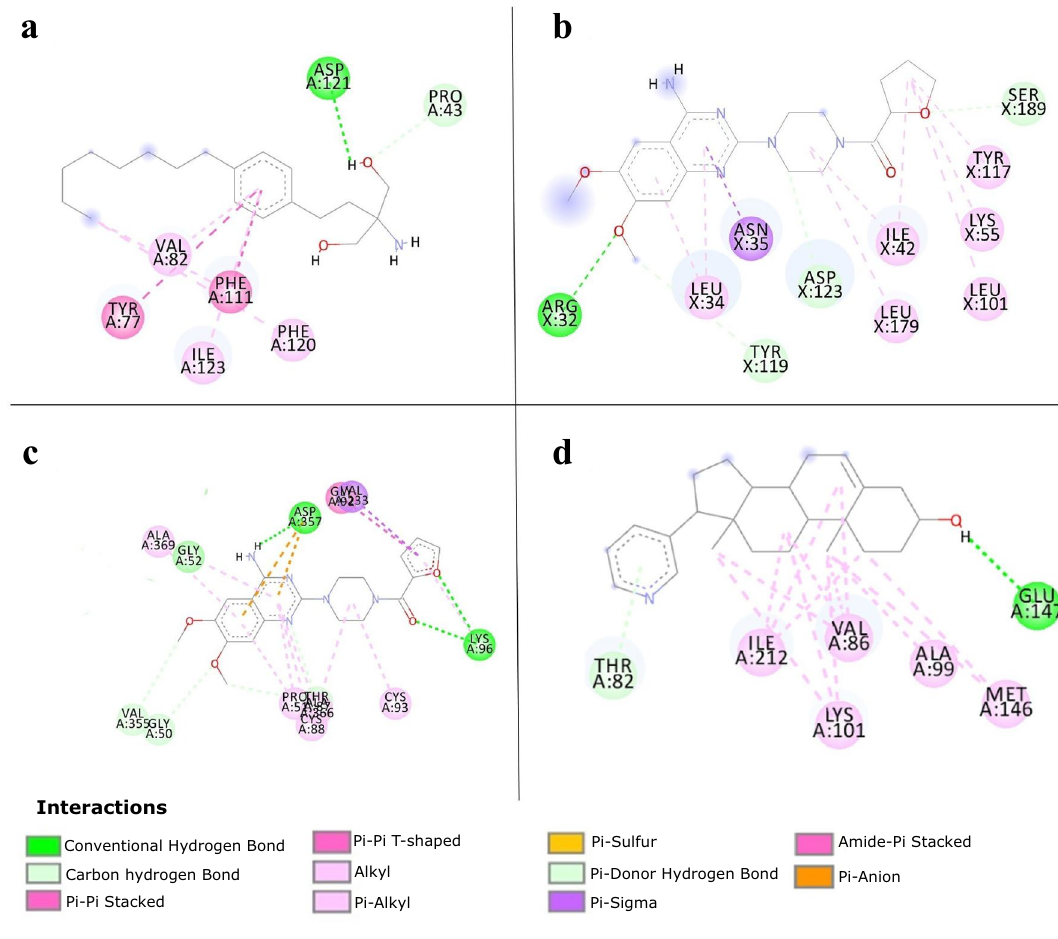
Figure 3. 2D plot of intermolecular interactions depicted using Discovery Studio Visualizer 2017 R2. ( A ) Fingolimod and Plasmepsin 2, ( B ) Terazosin PfPK7 and ( C ) Prazosin and PfTrxR ( D ) Abiraterone and PfCDPK2. Dashed lines represent the different interactions and their color the interaction type. Colored circles represent residues with their three letter code, chain identifier and residue